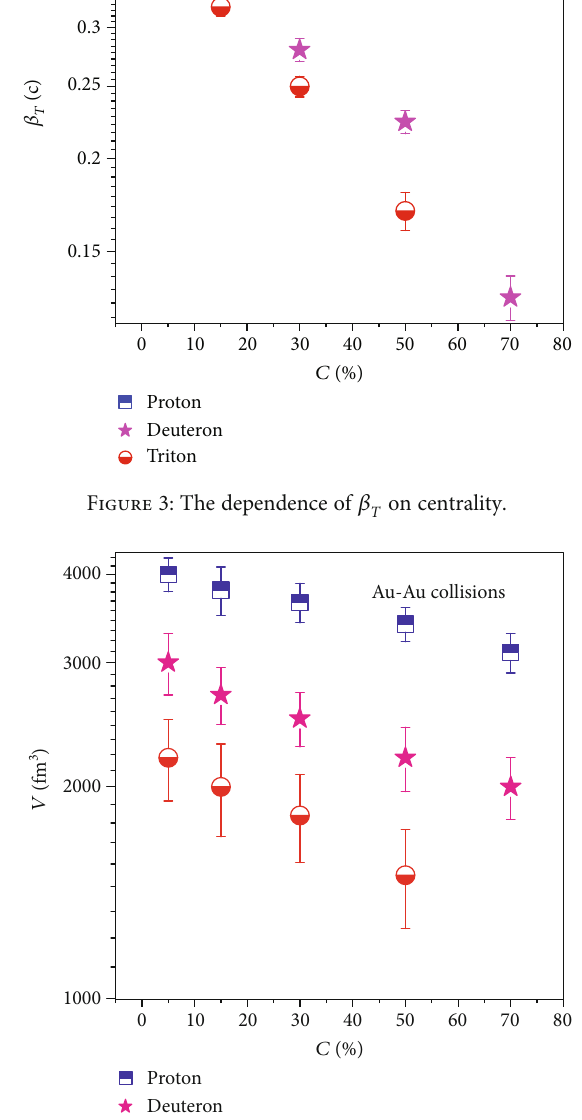
Figure 4: The dependence of V on centrality.